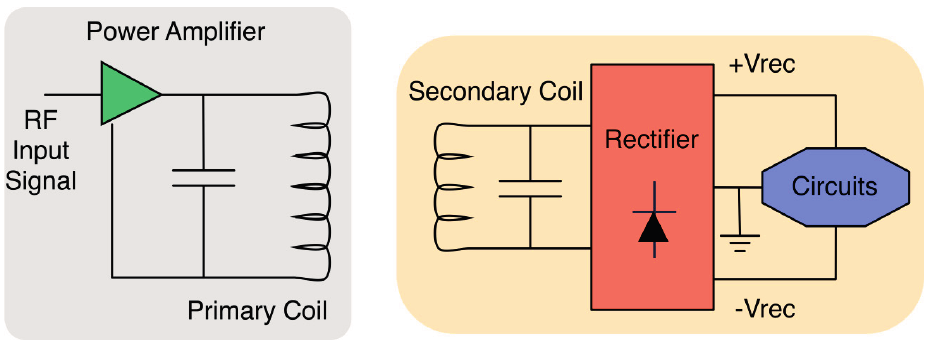
Figure 3. Generic wireless powering of an implantable